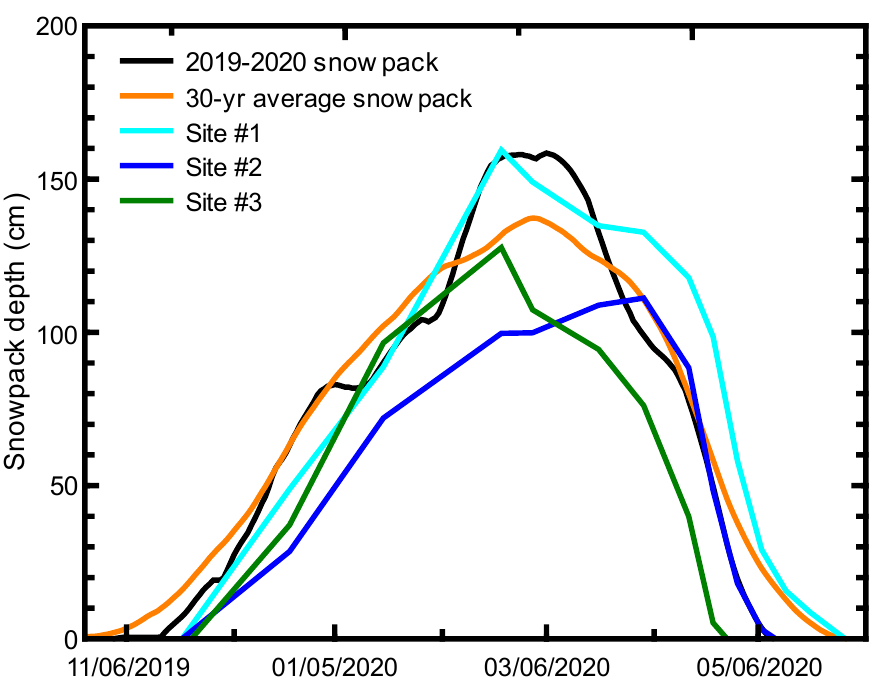
Figure 5. Snowpack depth for 2019 – 2020 and average snowpack depth, 1981 – 2010, for the Natural Resources and Conservation Service snow telemetry site at Moscow Mountain (site #989) [62] along with trendlines of snowpack-depth measurements at the three study sites (#1 – 3).